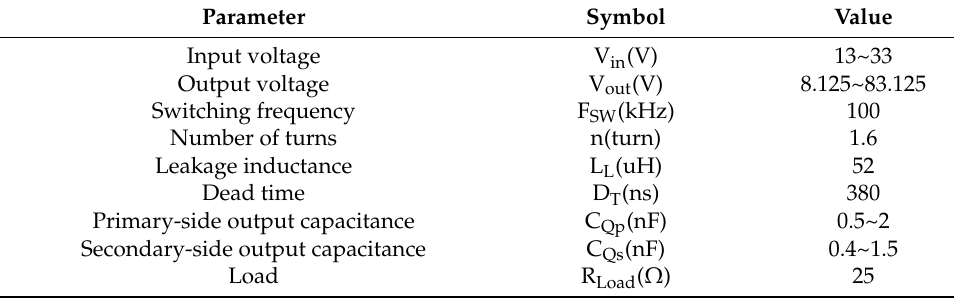
Table 2. DAB converter specification.